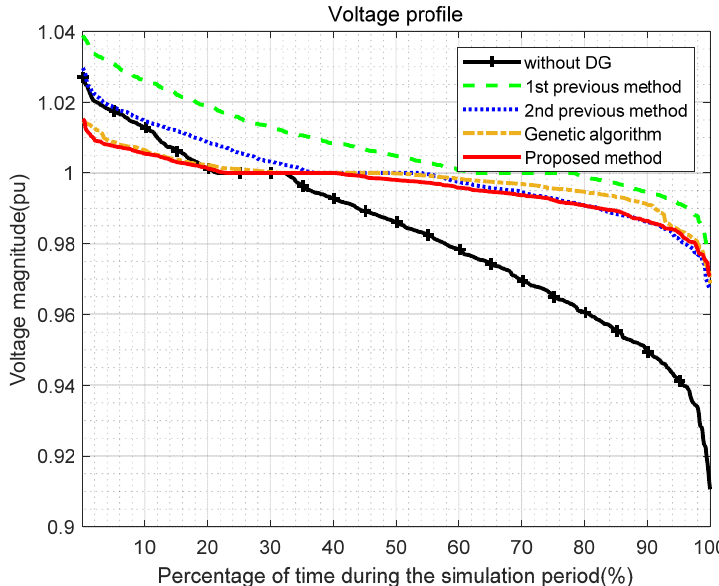
Figure 7. Voltage profile (the IEEE 30-bus test feeder). All the bus locations for 24 h.